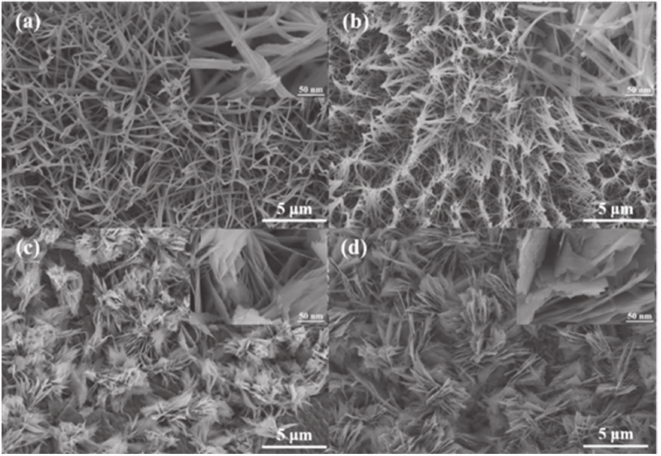
Figure 2. FESEM images of the samples prepared at 20 mA cm − 2 current density with di ff erent anodizing temperature ( a ) 25, ( b ) 40, ( c ) 60, and ( d ) 80